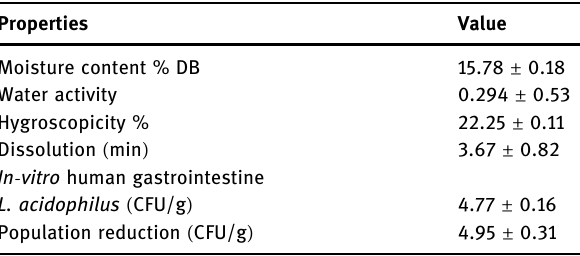
Table 8: Characterization of spray - drying – pasteurized fresh